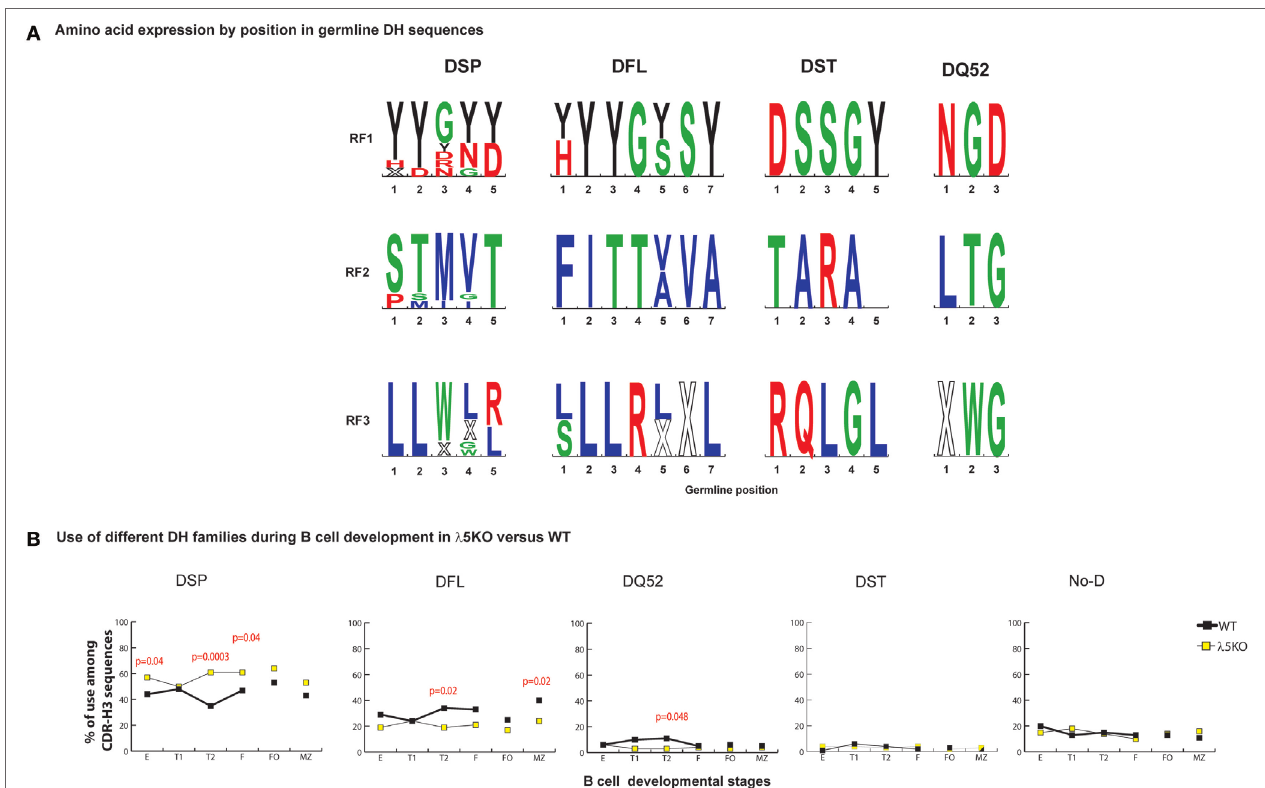
FigUre 2 | Differences in the use of D H families in λ 5KO versus wild-type (WT). (a) The rank order expression of amino acids of the different D H germline sequences as a function of reading frames (RF) based on position. The top panel presents the amino acid sequences encoded by RF1, the middle panel RF2, and the lower panel RF3. The four functional D H (DSP, DFL, DST, and DQ52) families are shown. Amino acids are color coded as described above. Stop codons are represented by an X. The size of the single letter is proportional to its prevalence. (B) Difference in use of individual D H gene families at selected B cell developmental stages in λ 5KO compared to WT. The p -values for differences that achieved statistical significance ( p ≤ 0.05) are